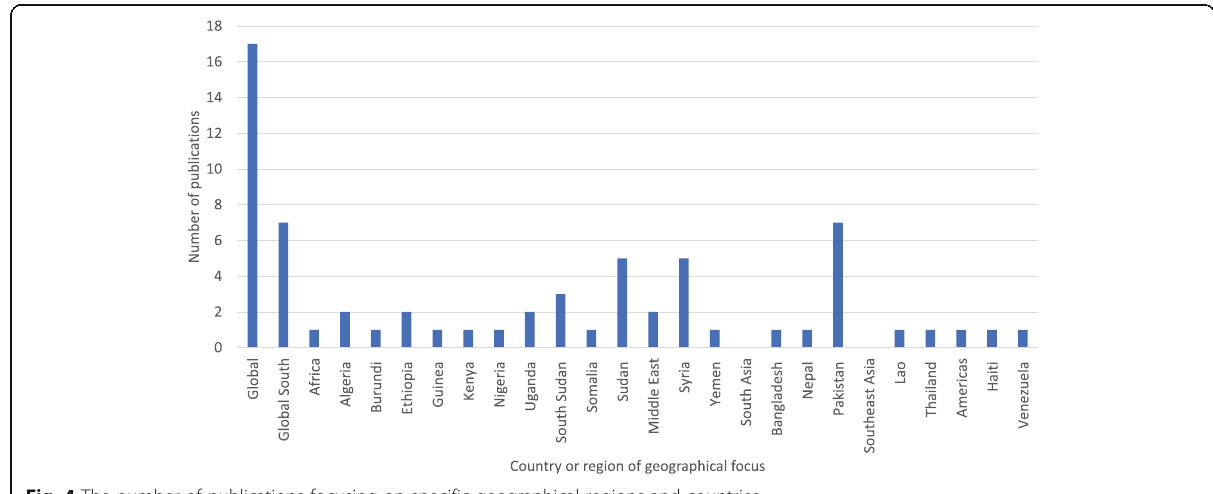
Fig. 4 The number of publications focusing on specific geographical regions and